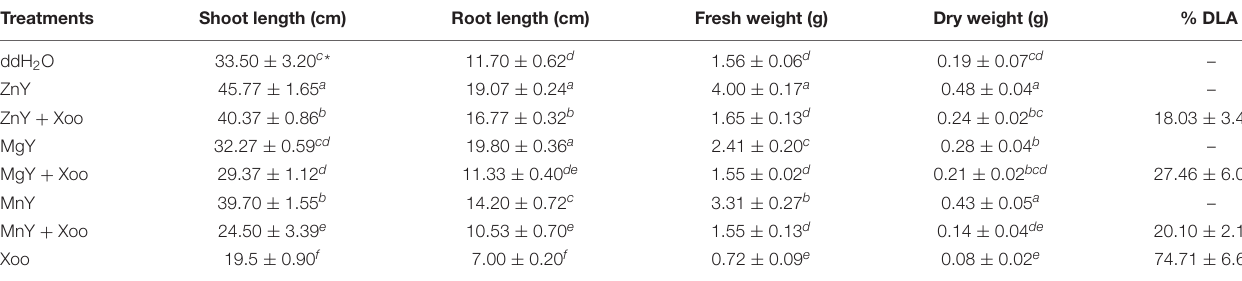
TABLE 2 | In vivo inhibitory effect of ZnO, MgO, and MnO 2 nanoparticles on Xoo strain GZ 0006. Treatments Shoot length